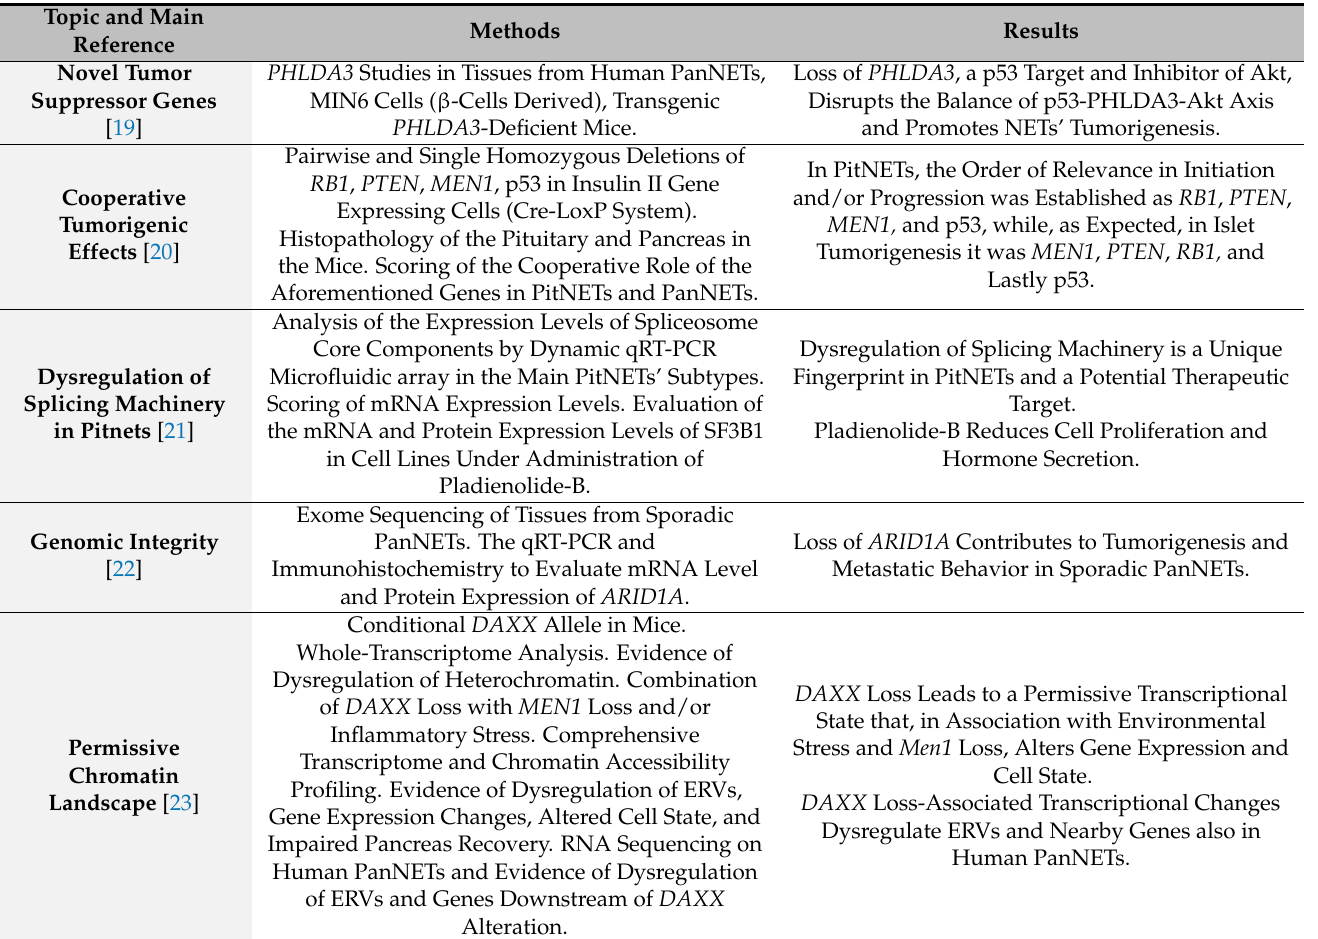
Table 1. The table summarizes the main references, methods used, and results described for the mechanisms elucidated in the different sections of the review. Quality criteria for the selected articles were: being published within the last 2 years in high-level scientific journals (first two quartiles in the field of interest, https://www.scimagojr.com, accessed on 5 August 2021); scientific soundness; literature-based and/or prior studies from the same authors; methods’ description; specific predictors to existing model [17]; limitations due to the use of animal models reported [18]; and presence of citations, though being recently